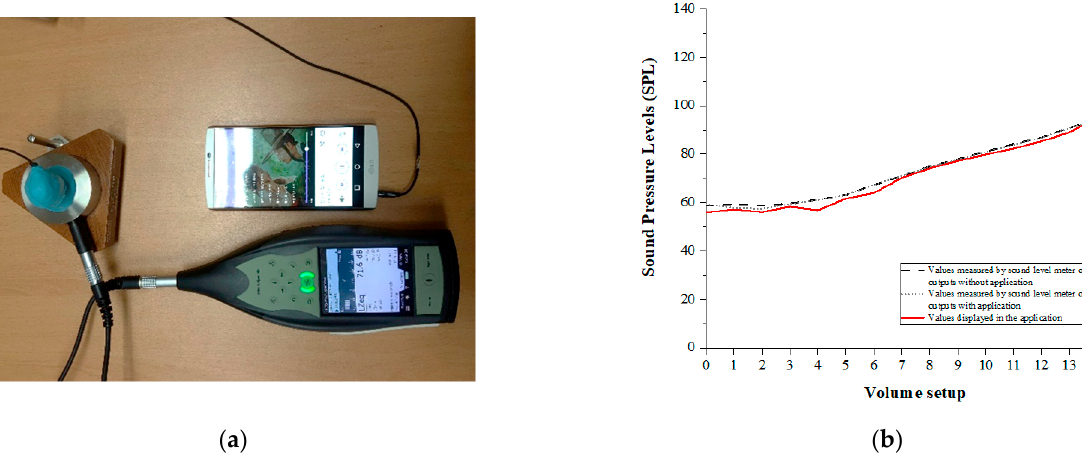
Figure 2. An example of sound pressure level measurement with an earphone connected to the application via a sound level meter and artificial ear simulator ( a ). The results of consistent level increasing with an increase of the volume steps in three measurement methods ( b ).